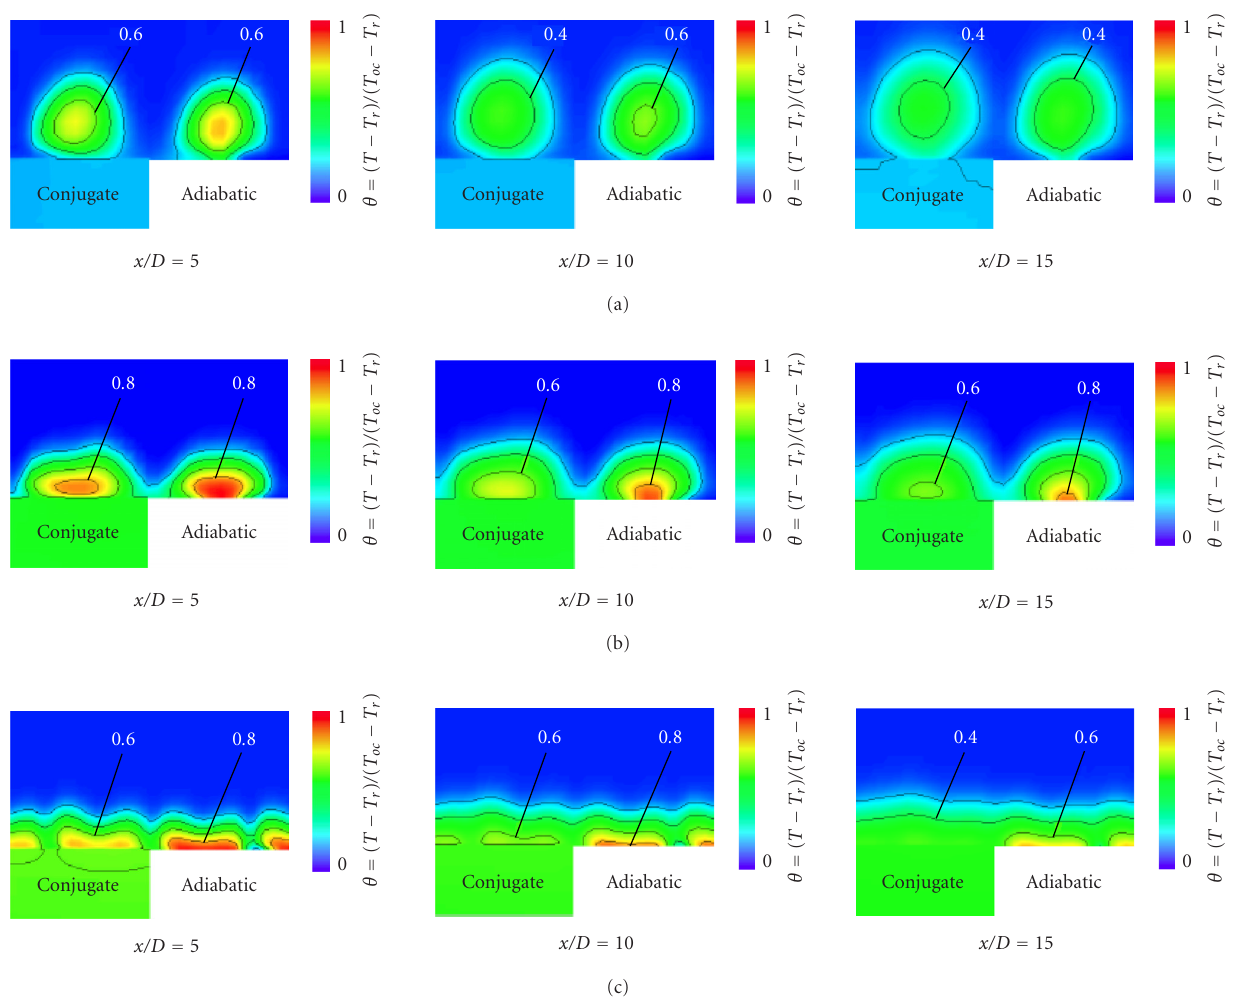
Figure 3: Nondimensional temperature distribution in x = const. Planes ( M = 2 . 0): (a) cylindrical hole ( ∆ T iso = 0 . 2), (b) di ff user hole ( ∆ T iso = 0 . 2), and (c) fanshaped hole ( ∆ T iso = 0 .